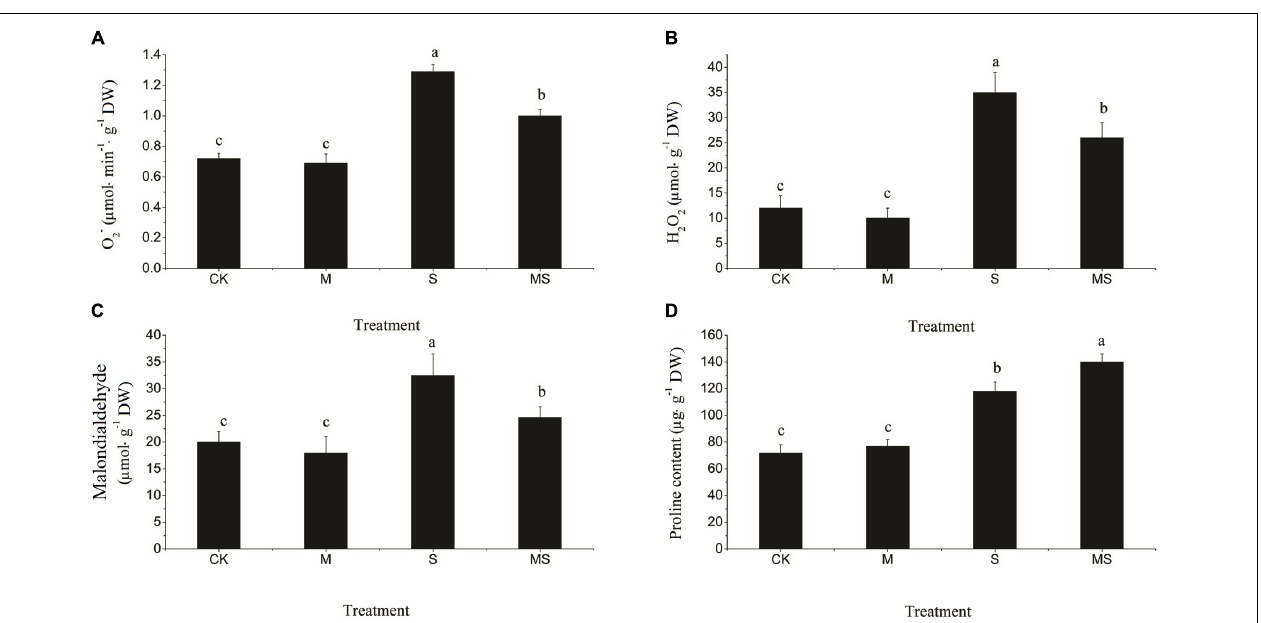
FIGURE 2 | Reactive oxygen species (O 2 •− and H 2 O 2 ), MDA, and proline content in watermelon seedlings in leaves of watermelon inoculated or non-inoculated seedlings with AMF Funneliformis mosseae and subjected or not to salinity-alkalinity stress. (A) O 2 •− content; (B) H 2 O 2 content; (C) MDA content; ( D ) Proline content. ROS, relative oxygen species; O 2 •− , superoxide anion; H 2 O 2 , hydrogen peroxide; MDA, malondialdehyde; AMF, arbuscular mycorrhizal fungi; CK, without AM inoculation + without salinity-alkalinity; M, with AM inoculation + without salinity-alkalinity; S, without AM inoculation + with salinity-alkalinity; and MS, with AM inoculation + with salinity-alkalinity. Values are means ± standard errors ( n = 10). Bars with different letters are significantly different at the 0.05 level (Duncan’s multiple range